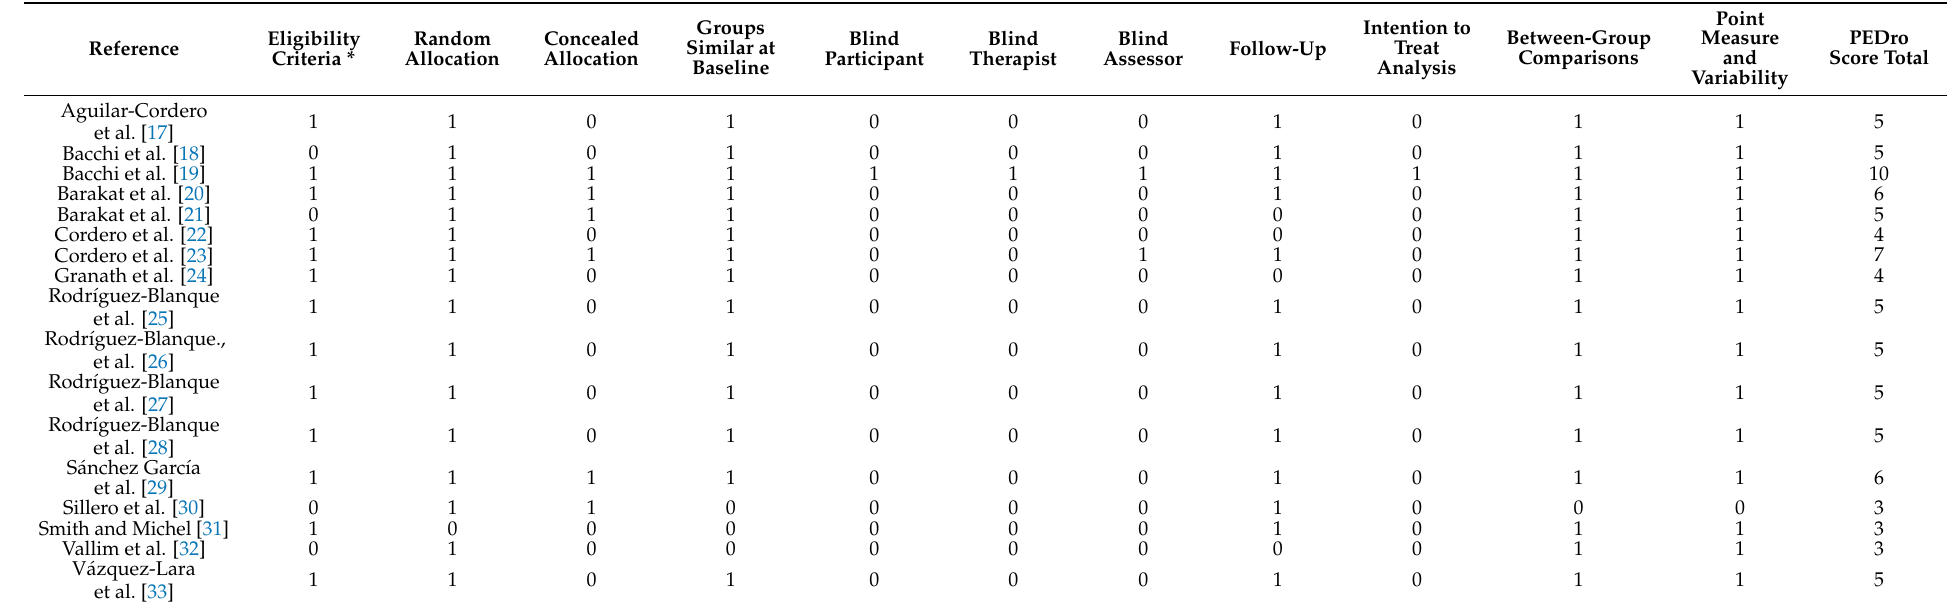
Table 2. PEDro Methodology quality for studies ( n = 17) included in the